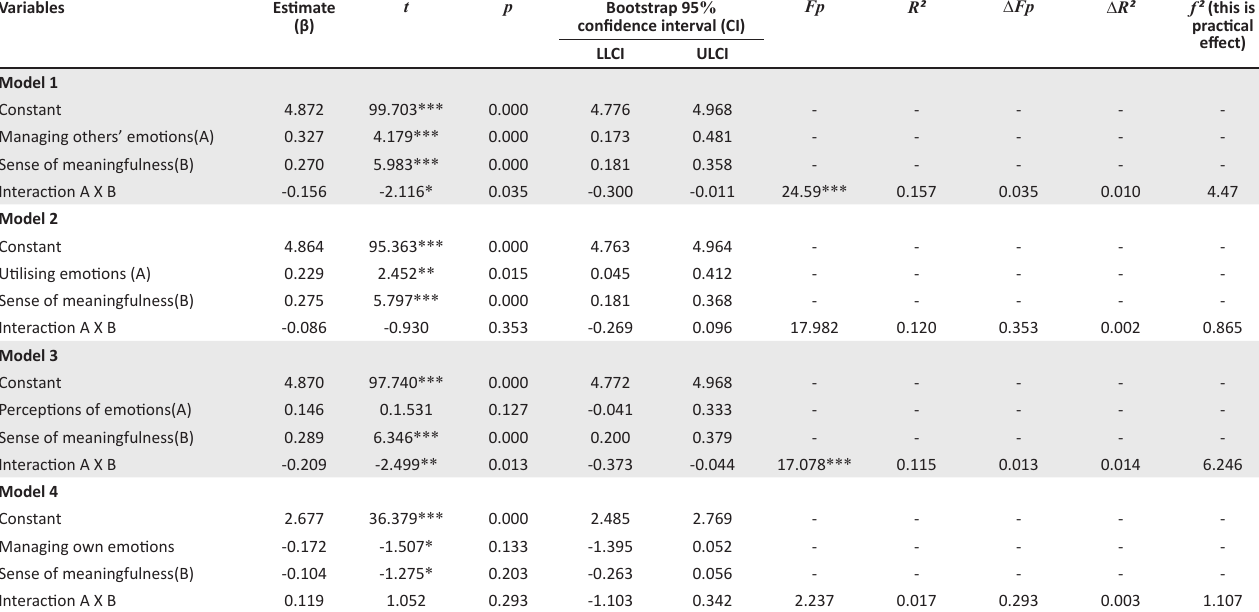
TABLE 3: Moderated regression results: Managing others’ emotions, utilising emotions, perceptions of emotions, managing own emotions moderated by sense of meaningfulness in predicting professional efficacy ( N = 409). Variables